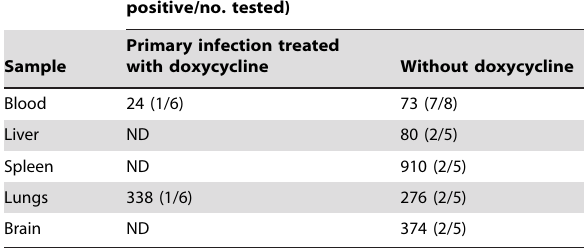
Table 2. Mean DNA copies of Rickettsia prowazekii in peripheral blood and various tissues sampled from doxycycline-treated or non-treated mice with dexamethasone-reactivated typhus infections.